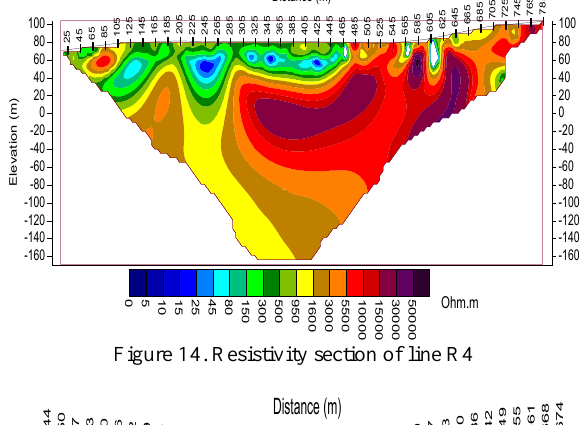
Figure 14. Resistivity section of line R4